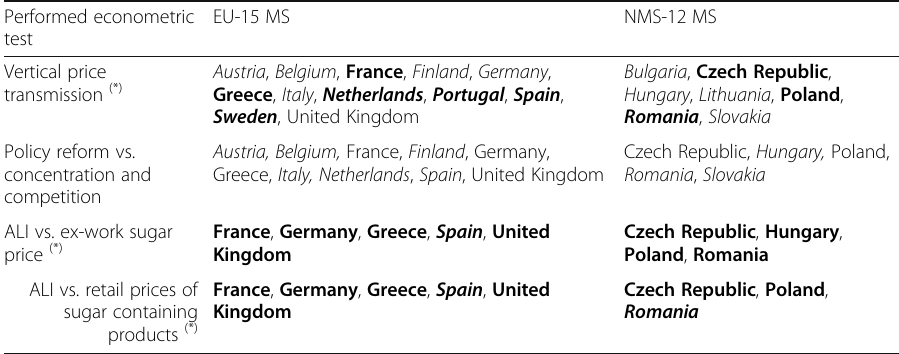
EU-15 MS NMS-12 MS